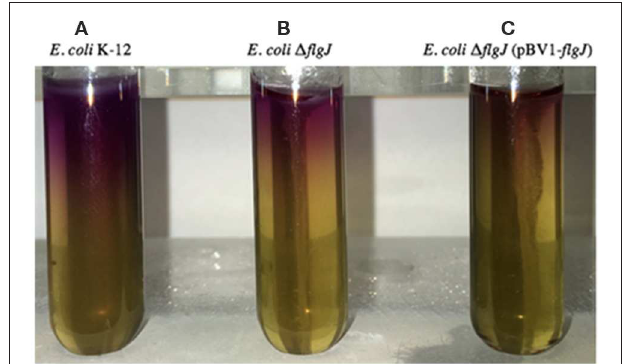
FIGURE 2 | Mobility assay of E. coli 1 flgJ measured using MIO medium. The lack of the flgJ gene evidences a decrease in the mobility of E. coli K-12. (A) E.